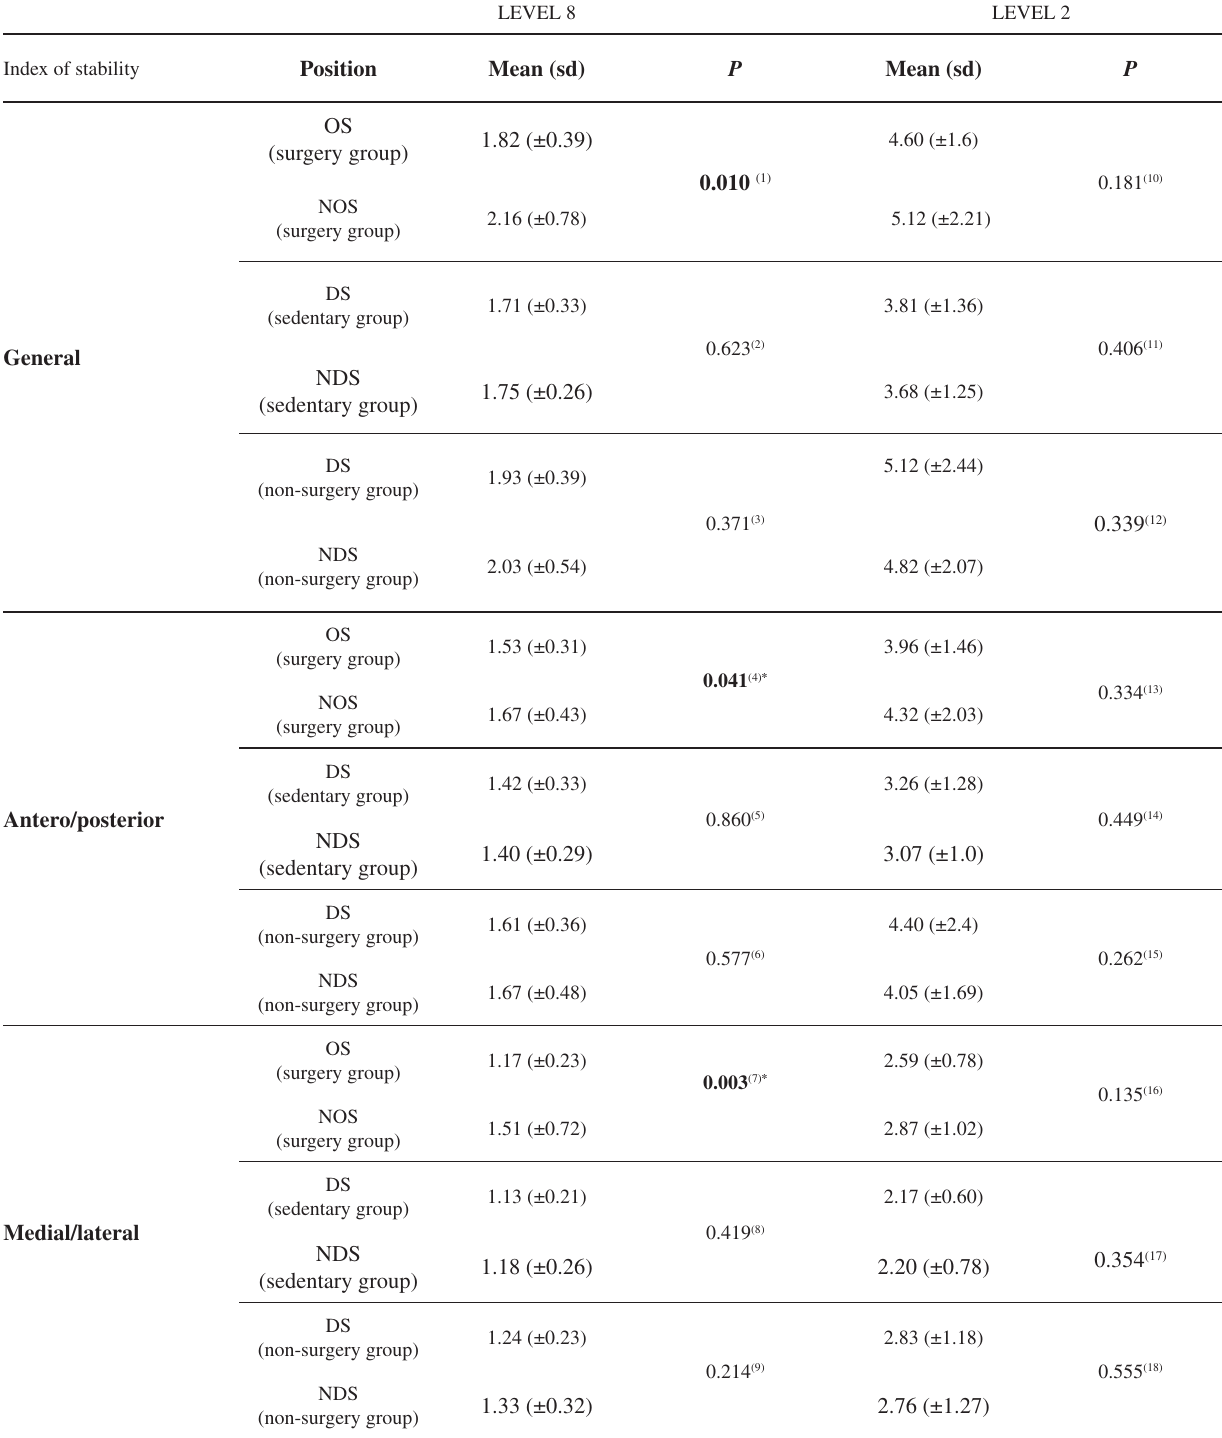
Table 1 - Intragroup comparison of the center of gravity dislocation and postural balance in the Surgery Group (OS versus NOS), Non-surgery Group (DS versus NDS), and Sedentary Group (DS versus NDS) at stability levels 8 and